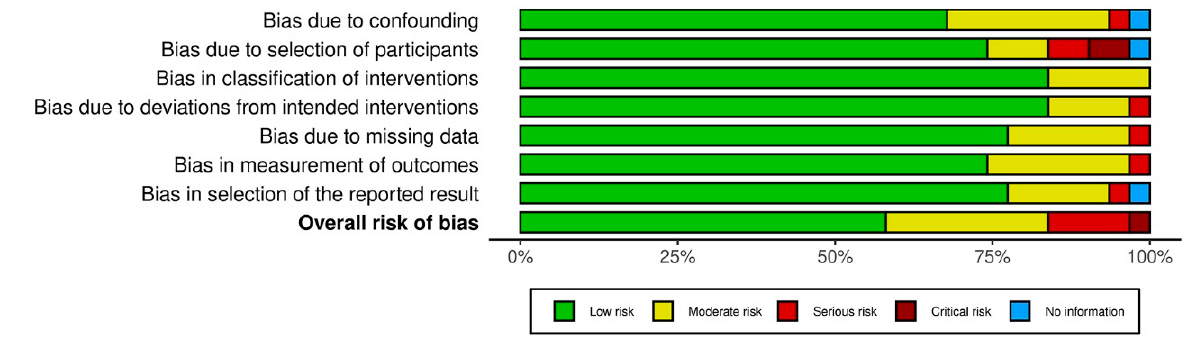
Figure 2. Risk of bias in randomized controlled studies. Overall results ( A ). Categories are presented as percentages ( B ).